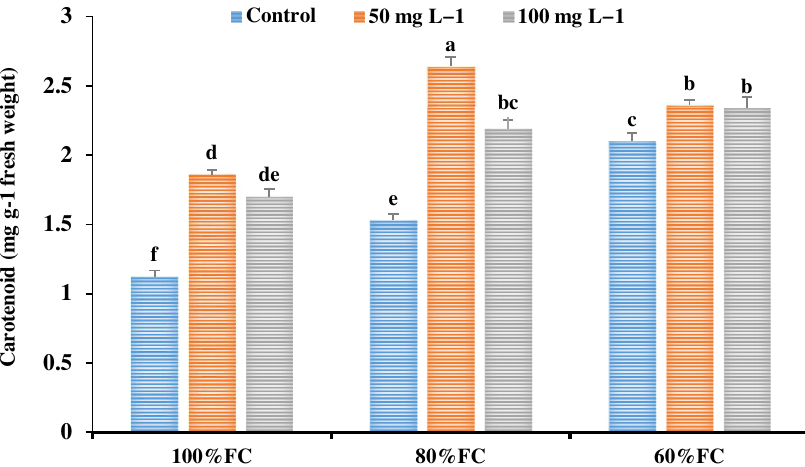
Figure 1. The content of chlorophyll a ( A ) and chlorophyll b ( B ) of basil in different irrigation regimes and Se NPs. Different letters indicate significant differences at the 5% level according to LSD’s test.